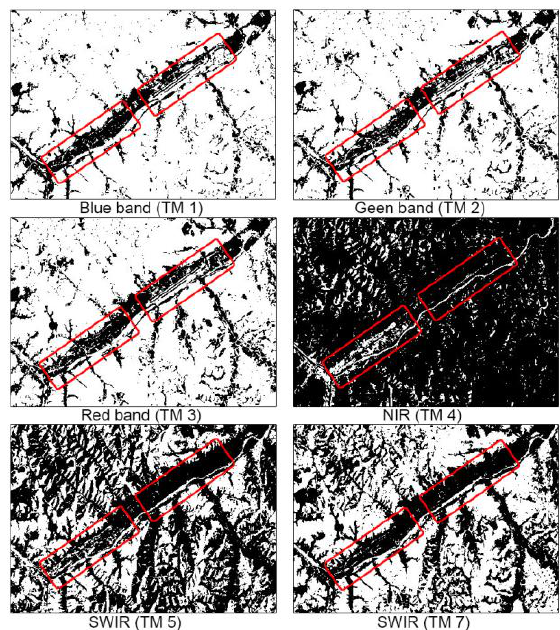
Figure 6. The local results of threshold segmentation in each band, and the segmentation effect of two key regions (built-up area and airport area) in Yan’an city The physical characteristics on each band of TM and the sensitivity to different ground objects should also be taken into consideration. TM1 refers to the blue band, which can reflect features under shallow water and distinguish soil and vegetation.